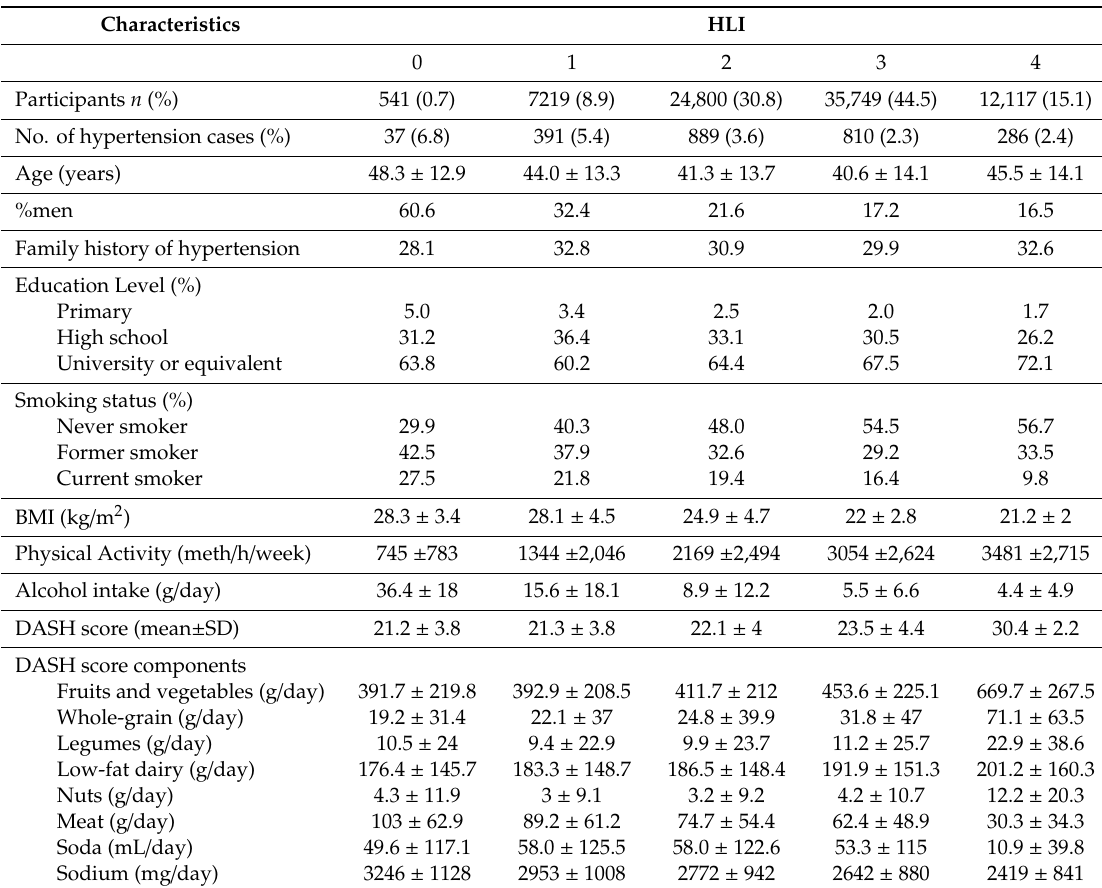
Table 2. Baseline characteristics of participants by Healthy Lifestyle Index (HLI)